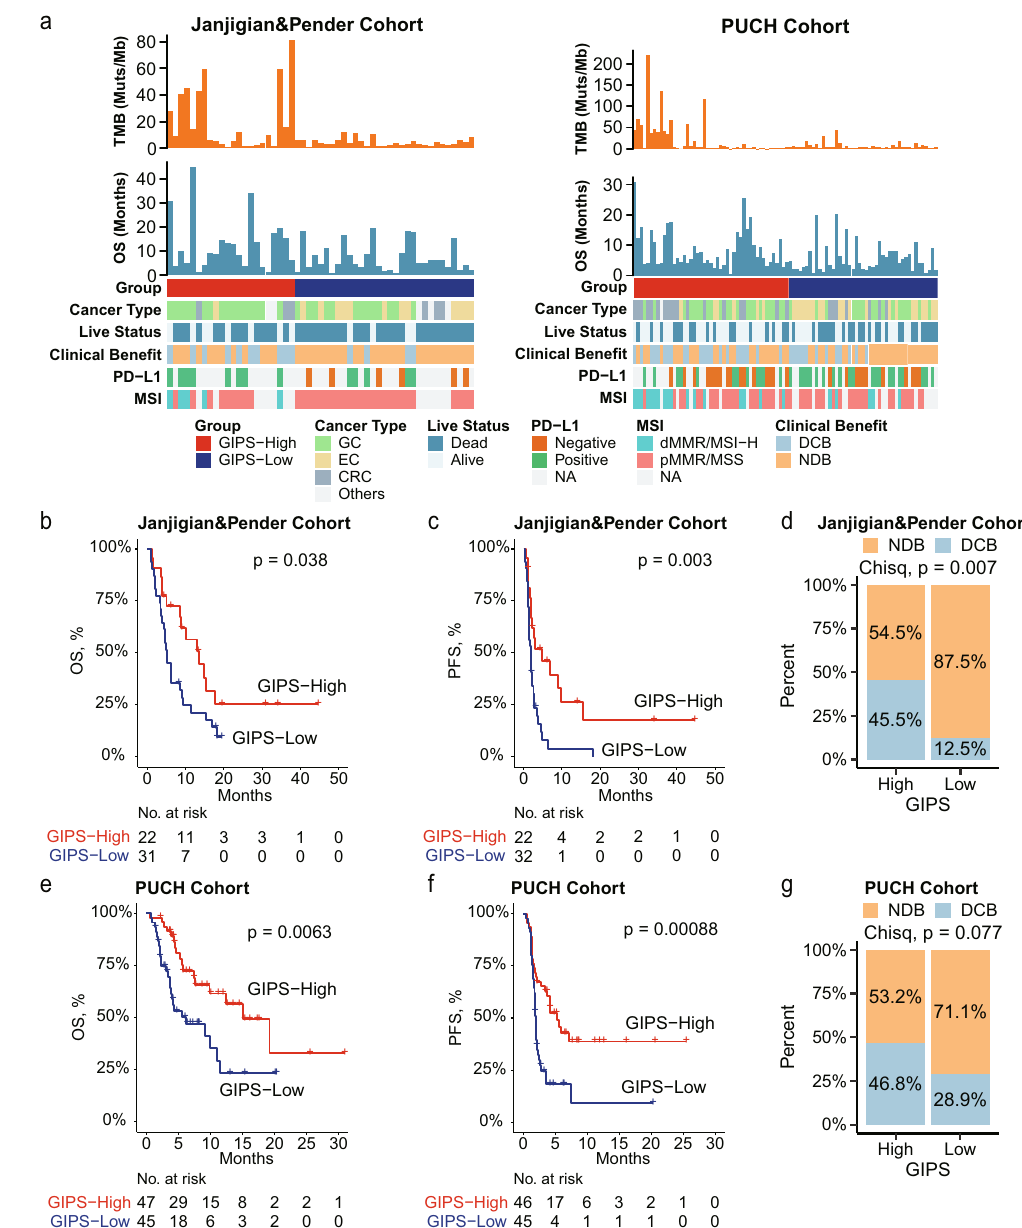
Fig. 2 GIPS is a prognostic biomarker and predicts immunotherapeutic bene fi t in two validation cohorts. a Heatmap of the clinical and molecular features associated with the GIPS-high and GIPS-low groups. b – d Kaplan – Meier curves of OS ( b ) and PFS ( c ), and the rate of durable clinical bene fi t ( d ) for patients with high and low GIPS scores in the Janjigian and Pender cohort. e – g Kaplan – Meier curves of OS ( e ) and PFS ( f ), and the rate of durable clinical bene fi t ( g ) for patients with high and low GIPS scores in the PUCH cohort. For Janjigian and Pender cohort, 53 patients had OS information. For PUCH cohort, 91 patients had PFS